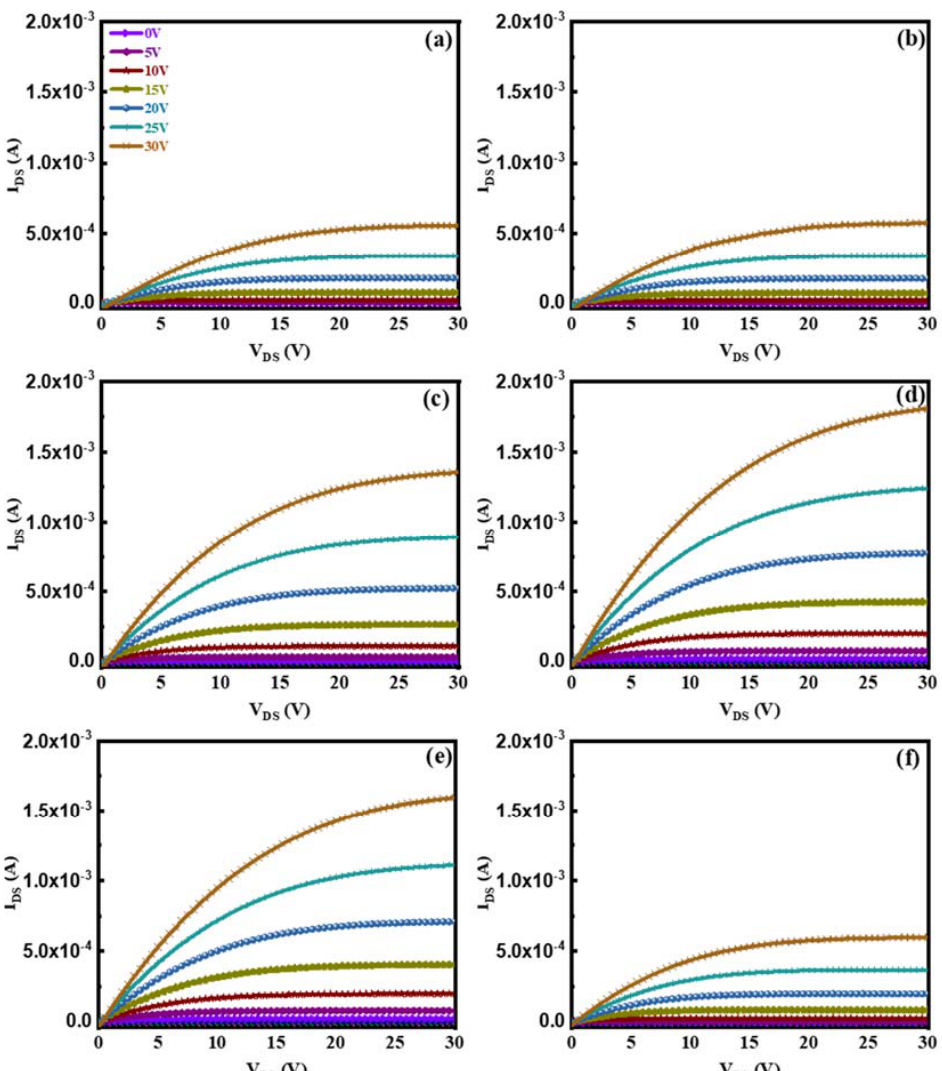
Figure 5. The output curves of ZnO:H/ZnO-TFTs fabricated with different H 2 /(Ar + H 2 ): ( a ) 0%, ( b ) 0.07%, ( c ) 0.13%, ( d ) 0.20%, ( e ) 0.27%, ( f ) 0.33%.